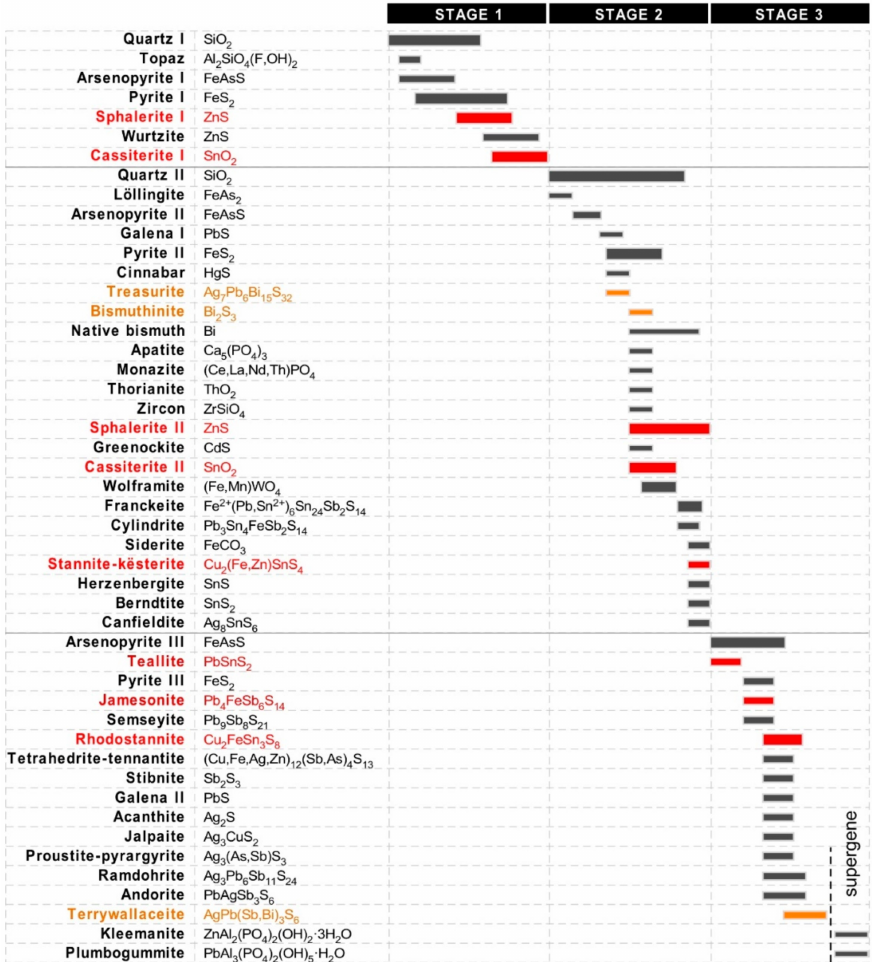
Figure 9. Paragenetic sequence obtained in this study for the Poop ó deposit. Notice critical element-bearing minerals highlighted in red (most abundant or richer in those elements) and orange (less abundant or poorer in those